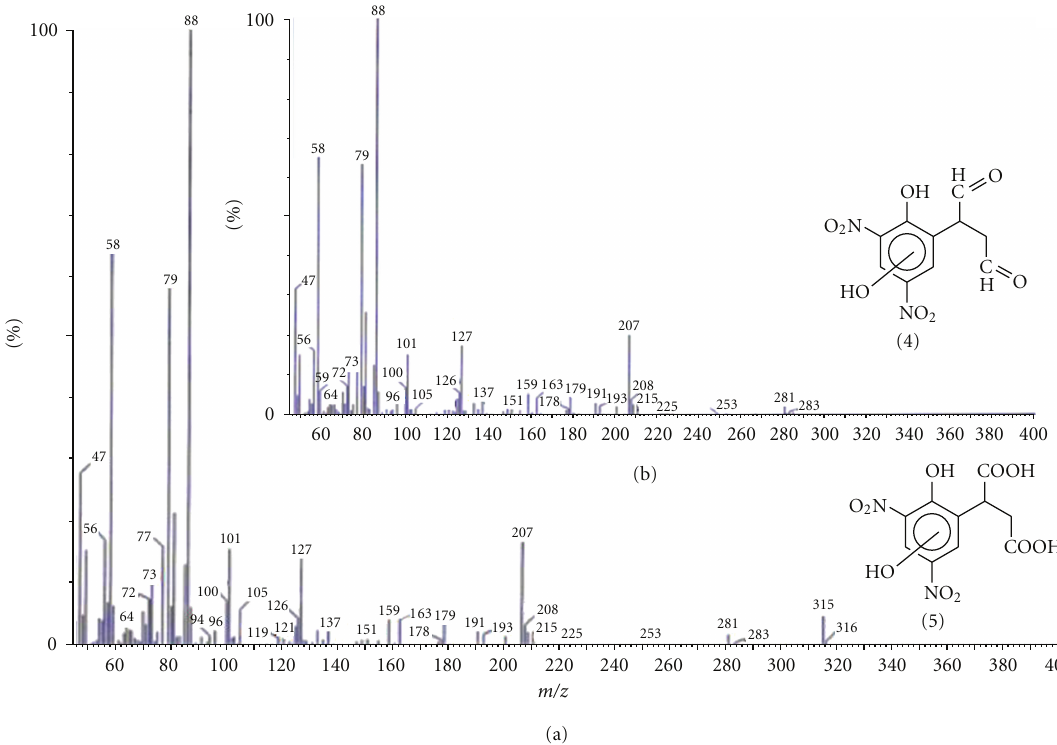
Figure 10: Mass fragmentation pattern of the two product peaks appearing at (a) R t 11.04 and (b) R t